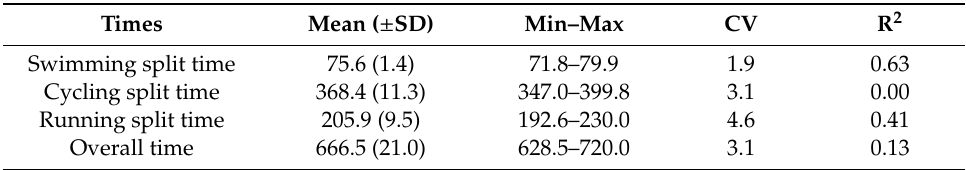
Table 1. Split and overall times (minutes), coe ffi cient of variance (CV) and goodness of fit in 2nd order polynomial regression (R 2 ) for 40 Ironman-distance triathlons for 40 consecutive